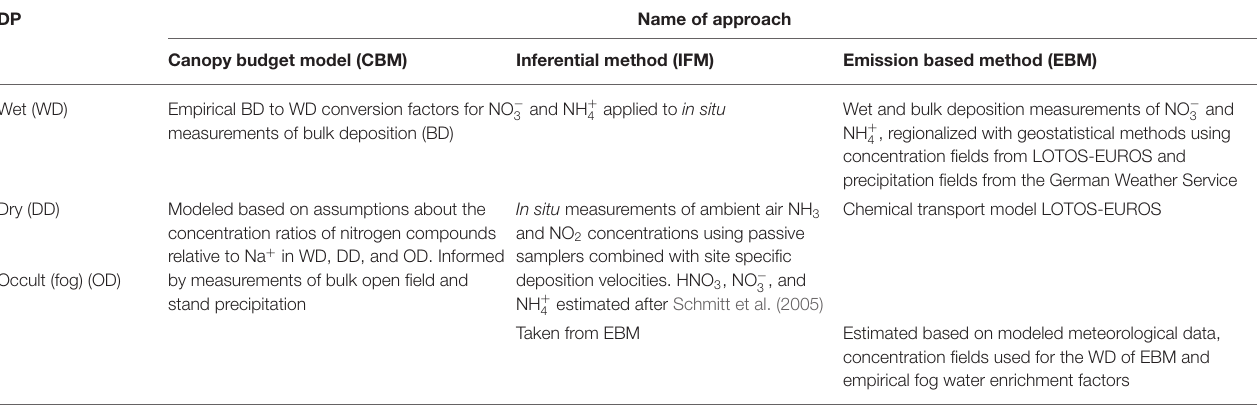
TABLE 1 | Calculation approaches of total inorganic nitrogen fluxes for the different deposition pathways (DP) and